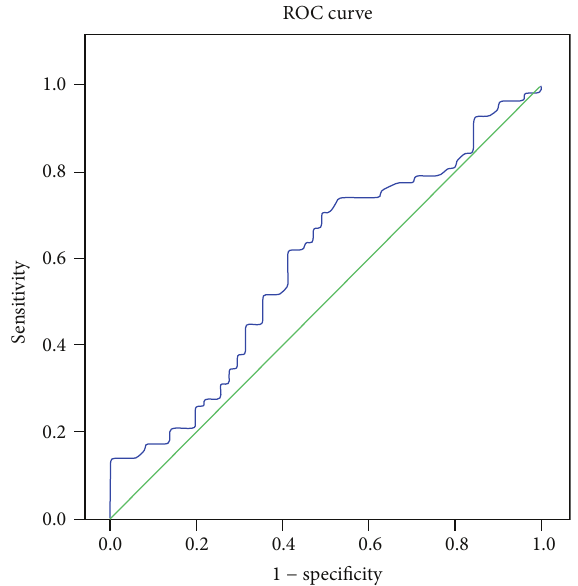
Figure 1: The ROC curve of BDNF plasma level and aMCI. Figure 2: The ROC curve of olfactory deficit and aMCI.